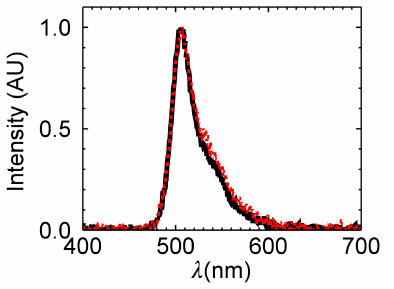
Figure 7. Fluorescence emission spectrum of EGFP before and after photodepletion. The initial spectrum (black line) before photodepletion is virtually identical to the spectrum (red line) taken at a photodepletion fraction of 0.87. Both spectra have been scaled to a maximum amplitude of one to facilitate visual comparison.